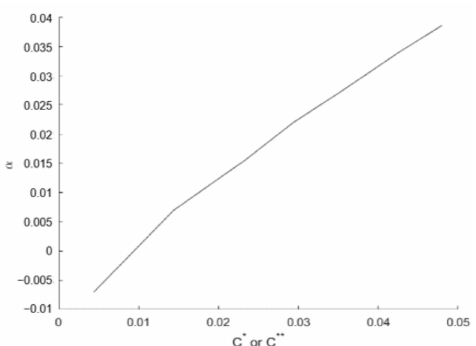
Figure 22. Relationship between α and C ∗ (or C ∗∗